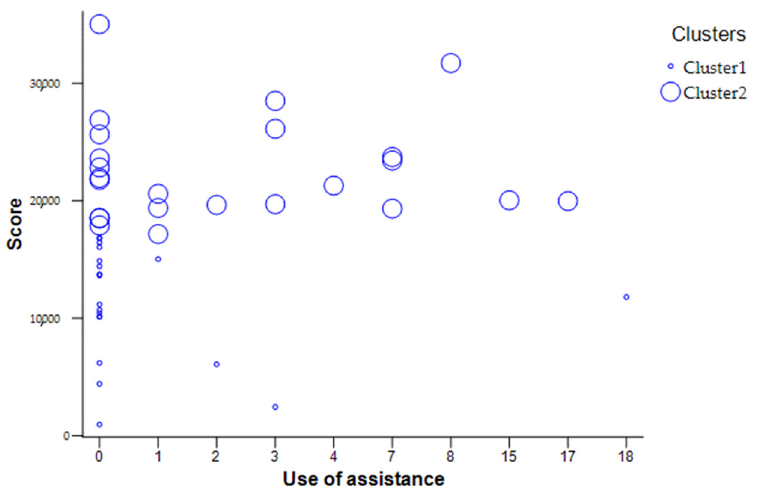
Figure 8. Graphical representation of clusters formulated from the data of score and the use of assistance system.